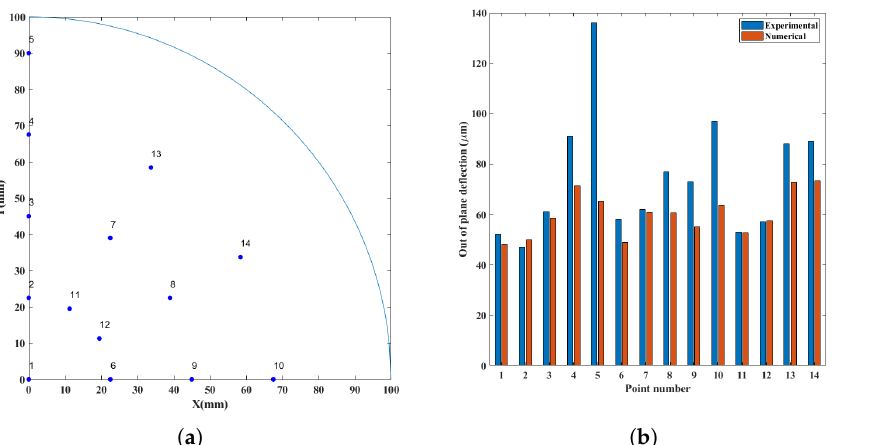
Figure 19. Comparison of numerical and experimental out-of-plane displacements: ( a ) point coordi- nates on the wafer surface; ( b ) out-of-plane